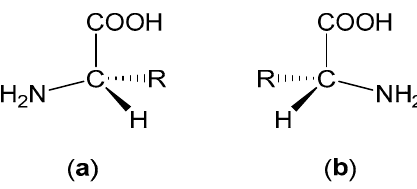
Figure 4. ( a ) Structure of an L -amino acid. ( b ) Structure of a D -amino acid.